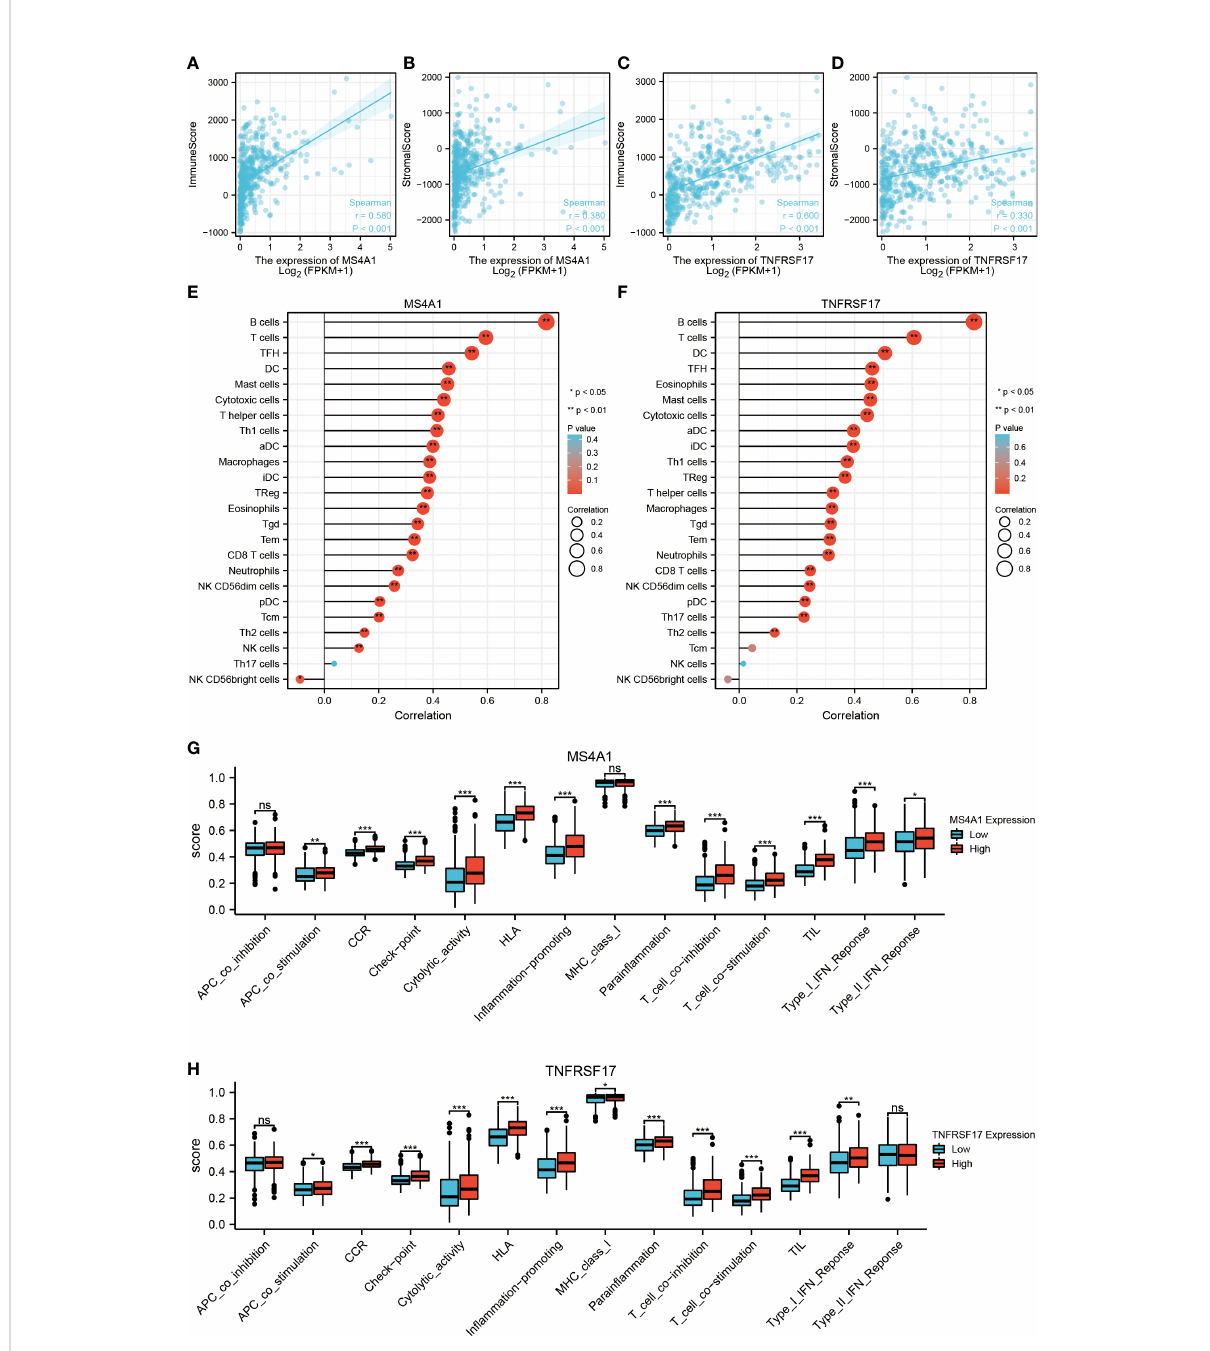
FIGURE 5 Relationship between the target genes and immune in fi ltration. (A) Correlation between MS4A1 expression and immune scores. (B) Correlation between MS4A1 expression and stromal scores. (C) Correlation between TNFRSF17 expression and immune scores. (D) Correlation between TNFRSF17 expression and stromal scores. (E) Relationship between MS4A1 expression and immune cell in fi ltration in TME. (F) Correlation between TNFRSF17 expression and immune cell in fi ltration in TME. (G) Comparison of the immune status between the high- and low-MS4A1- expression groups. (H) Comparison of the immune status between the high- and low-TNFRSF17-expression groups. *,<0.05; **,<0.01; ***, <0.001;